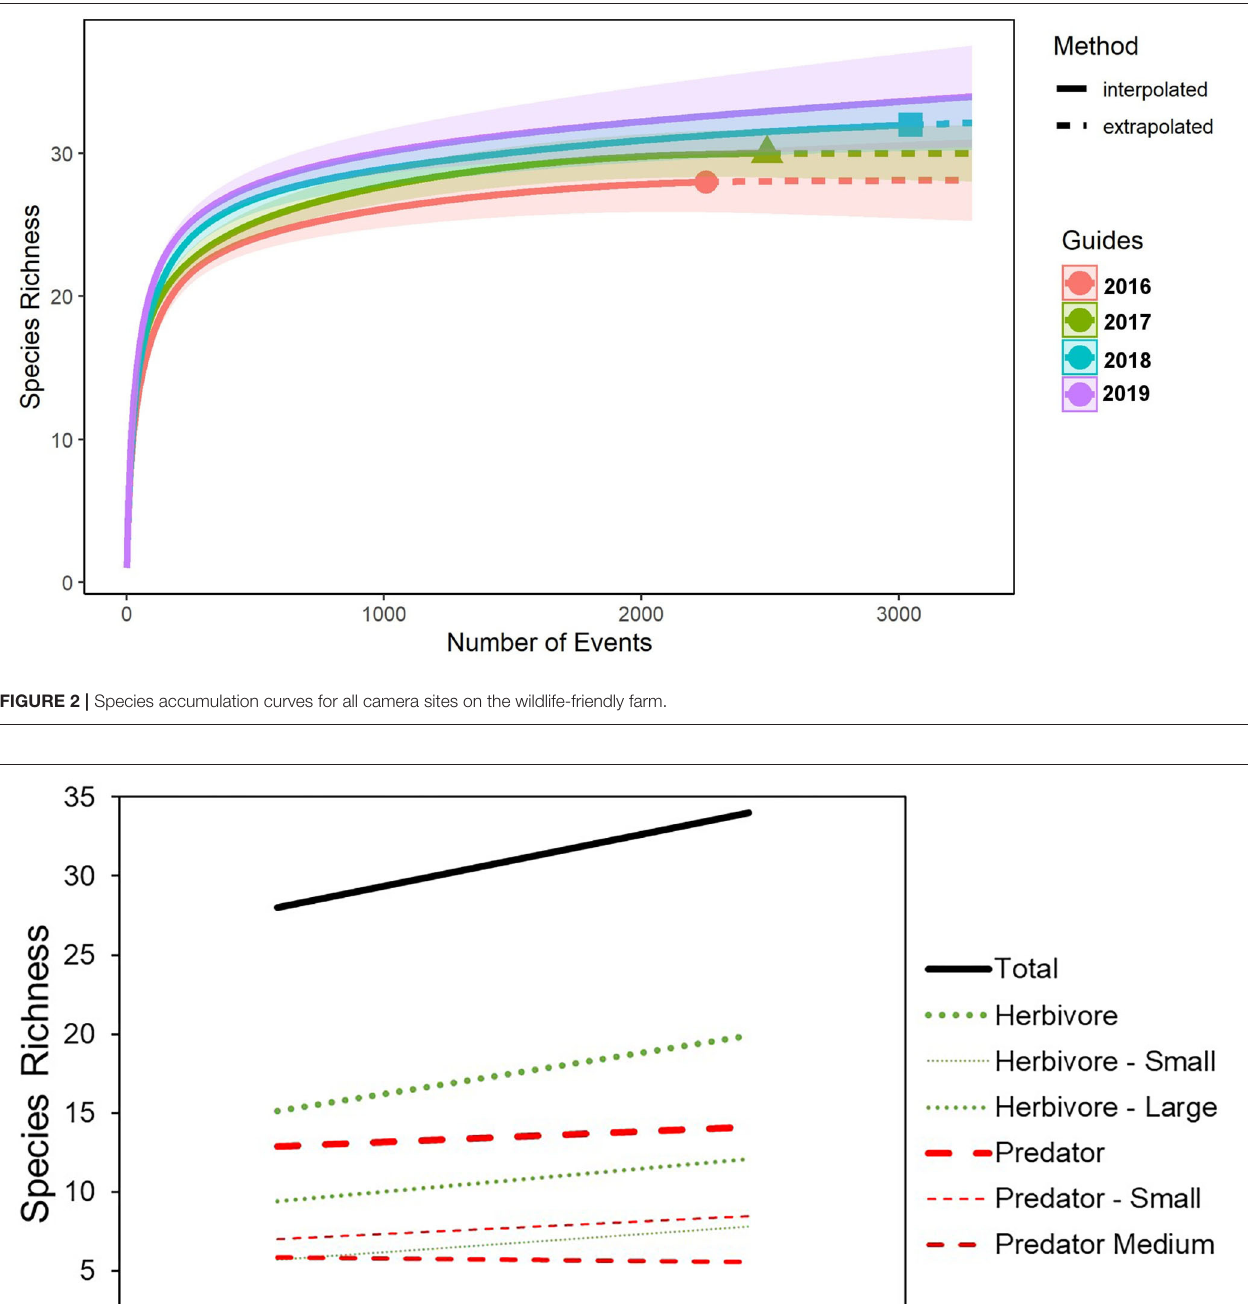
not detected on the wildlife-friendly farm but were present on the game farm. The traditional farm detected a single species (leopard) that was not present on the wildlife-friendly farm.